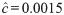
Discrete-time SIS (blue) and continuous-time SIS (orange) dynamics for delays Δ = 0 to Δ = 5.N = 10, 000, b0 = 0.05, γ = 0.08, c^=0.0015, α = 0.375, and I0 = 1. Here the epidemic equilibrium is I^=35.72.